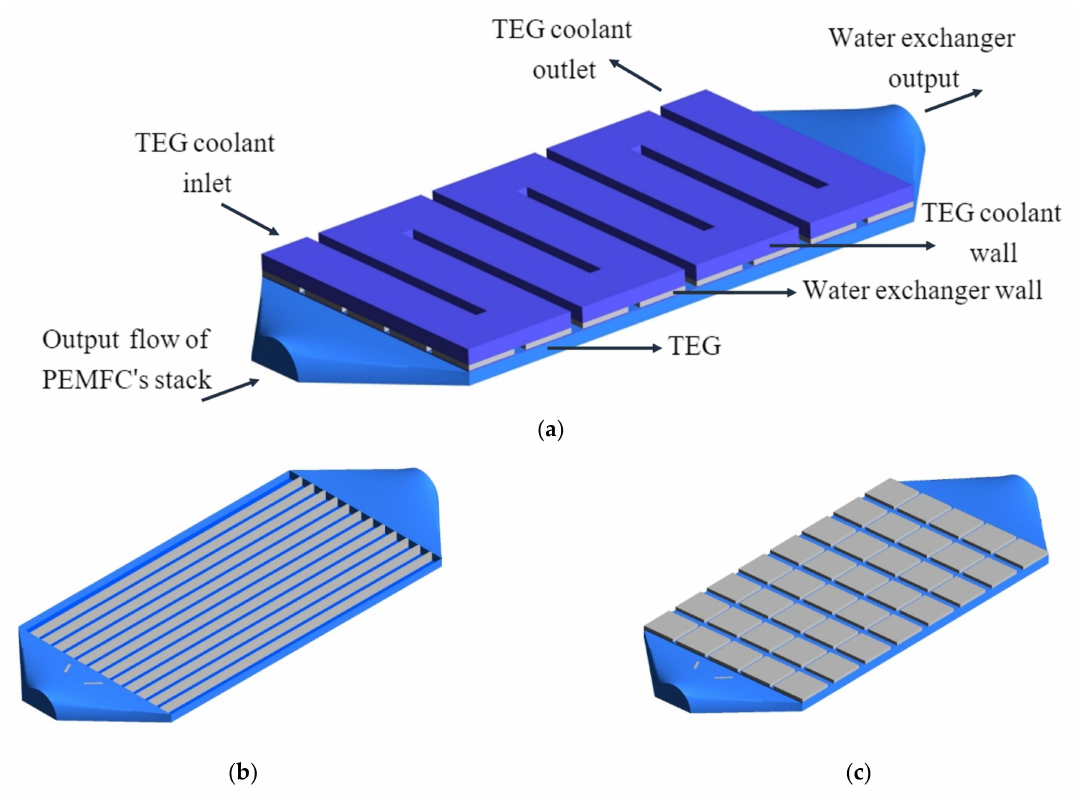
Figure 6. Schematic of the TEG unit for waste heat recovery: ( a ) assembled unit; ( b ) water channels on the hot side of the TEG; ( c ) arrangement of the 40 TEG modules in the